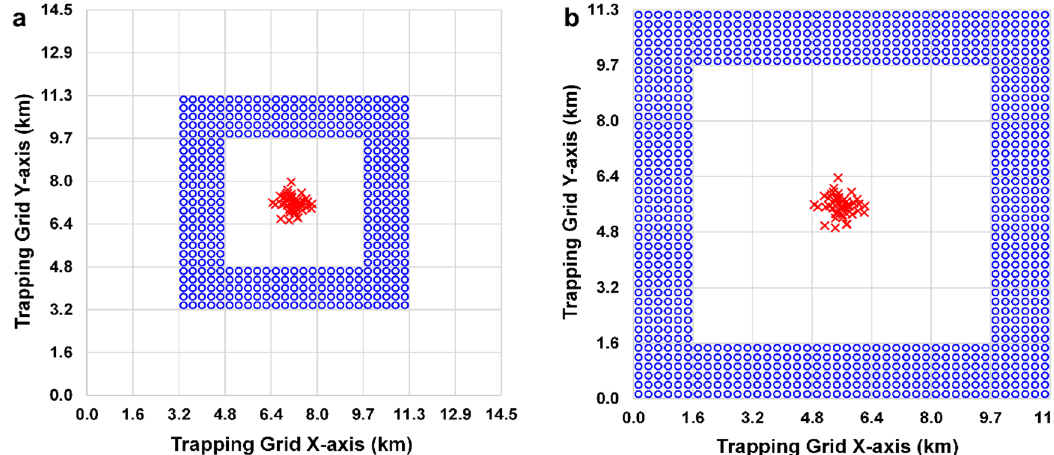
Figure 2. Examples of perimeter designs for band contribution and containment testing. ( a ) Contribution test of Band 3 of the Medfly design with 9.7 traps per km 2 ; ( b ) Containment testing grid for the leek moth design with 13.9 traps per km 2 . Each cell is 2.59 km 2 , blue circles represent traps, and red crosses indicate outbreak